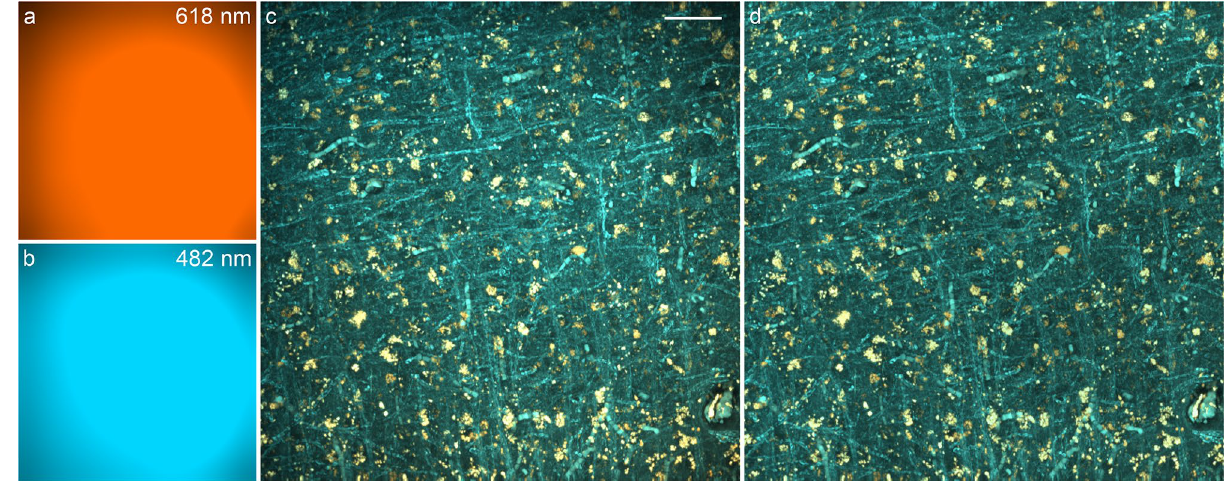
Figure 6. Example of the CIDRE-based tile illumination correction (MIPs, scale bar: 50 µ m ): ( a ) spatial intensity gain model at (cid:31) = 618 nm (neurons); ( b ) gain model at (cid:31) = 482 nm (myelinated fibers); ( c ) original TPFM tile (stack size: 450 µ m 450 µ m 71 µ m , acquisition time: 3 min 33 s); ( d ) corrected TPFM tile (zero- × × light preserved mode 30 ).